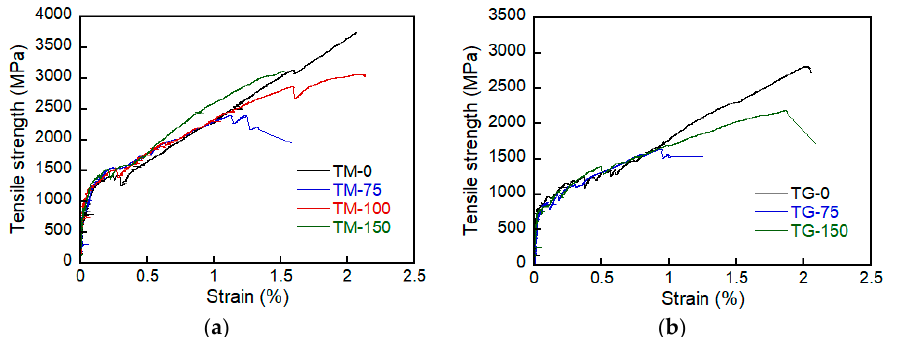
Figure 7. Axial stress-strain curve of specimens. ( a ) TM series; and ( b ) TG series. Overall, 𝑓 (cid:3033)(cid:3048) of the TM series specimens increased as 𝐿 (cid:3013)(cid:3020) increased. However, 𝑓 (cid:3033)(cid:3048) did not increase further for the lap splice length that was greater than 100 mm. Therefore, the minimum 𝐿 (cid:3013)(cid:3020) of the TM series specimens can be considered as 100 mm. On the other hand, the initial cracking strength ( 𝑓 (cid:3030)(cid:3045) ) and the ultimate tensile strain ( 𝜀 (cid:3033)(cid:3048) ) did not give consistent results with respect to 𝐿 (cid:3013)(cid:3020) . Similar behavior was also observed for the TG series specimens, but the testing variable ( 𝐿 (cid:3013)(cid:3020) ) was not sufficient to clearly identify the minimum 𝐿 (cid:3013)(cid:3020) . The maximum value of 𝑓 (cid:3033)(cid:3048) of the TM and TG series specimens with the lap-spliced panel is at most 84.6% and 78.6% of the specimen with the full-length panel (no lap splice). Although the compressive strength of the mortar (TM series) is about 78% of that of the grout (TG series), for the same value of 𝐿 (cid:3013)(cid:3020) , 𝑓 (cid:3033)(cid:3048) of the TM series specimens was al- most two times greater than that of the TG series specimens. Furthermore, 𝑓 (cid:3030)(cid:3045) of the TM series was at least 27% greater than that of the TG series. Note that 𝑓 (cid:3030)(cid:3045) is the initial crack- ing load divided by the cross-sectional area of the matrix (transition zone). Therefore, the influence of the matrix properties on 𝑓 (cid:3033)(cid:3048) and 𝑓 (cid:3030)(cid:3045) is significant.